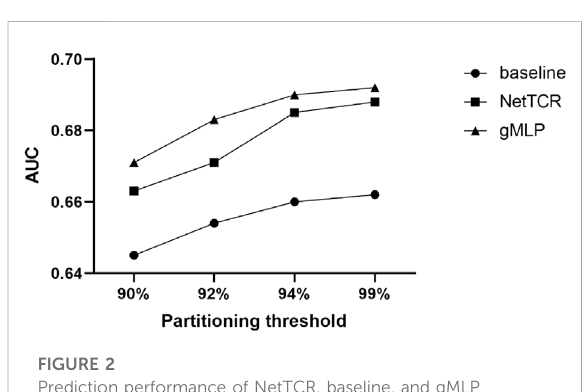
FIGURE 3 Comparing the prediction performance of baseline,